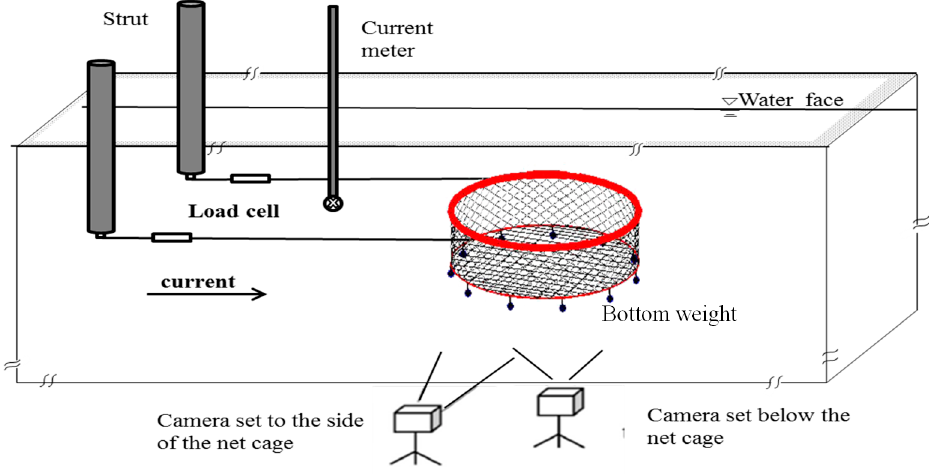
Figure 3. Schematic of experiment setup.